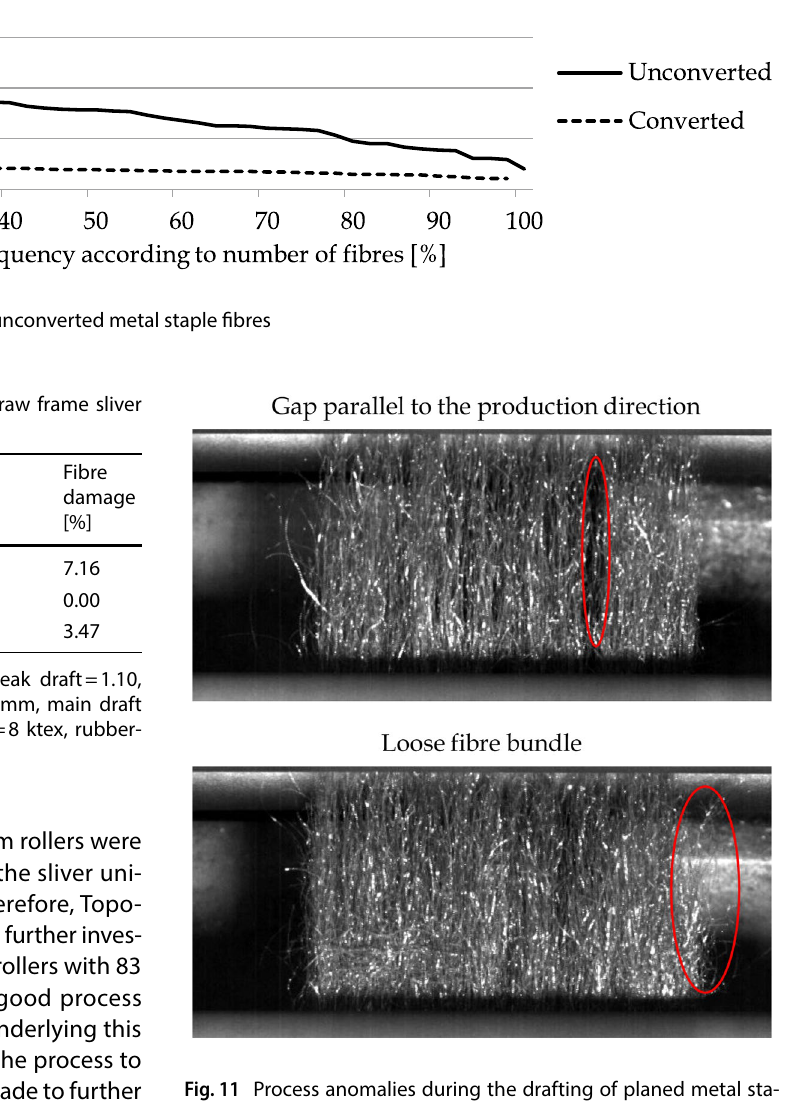
Fig. 11 Process anomalies during the drafting of planed metal sta- ple